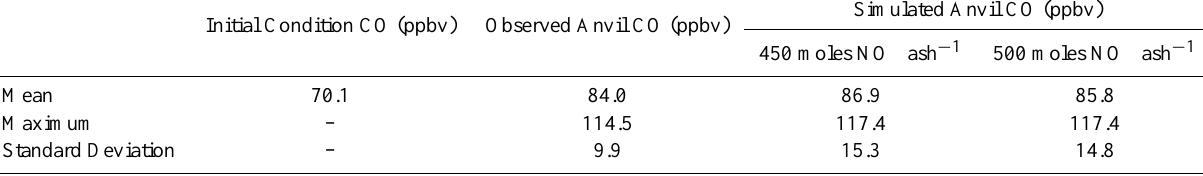
Table 3. Egrett observed and simulated CO mixing ratio statistics for the layer centered at 13.4km. Simulated values are based on a lightning NO production scenario of 450 and 500molesflash − 1 . The layer centered at 13.4km contained 351 11-s Egrett observations and 1268 simulated values.